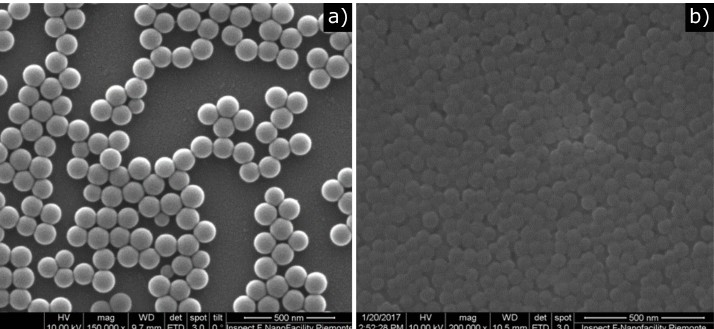
Figure 1. Representative scanning electron microscopy (SEM) image of the polystyrene nanoparticles: ( a ) sample PS120, ( b ) sample